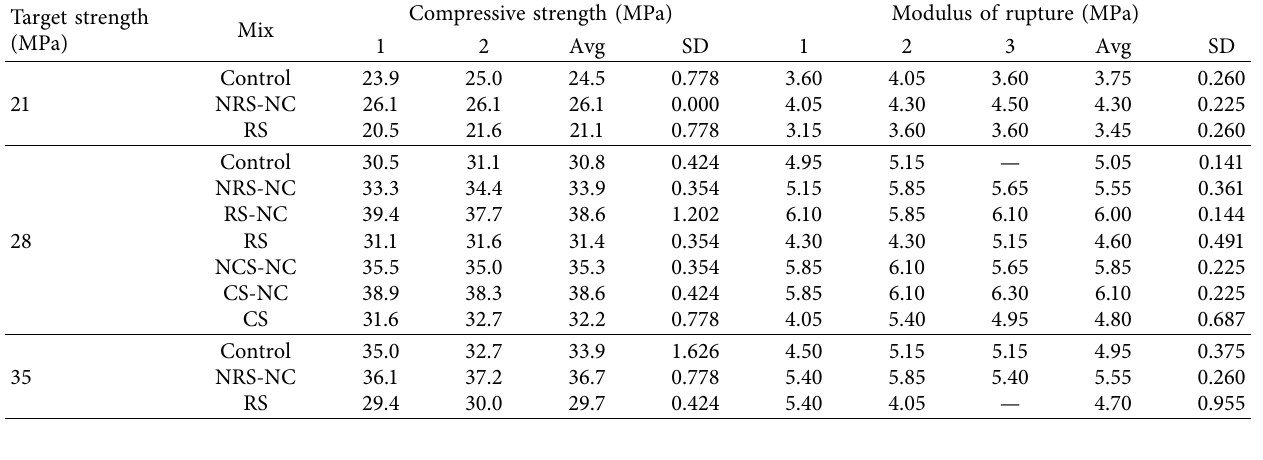
Table 5: Compressive strength and modulus of rupture